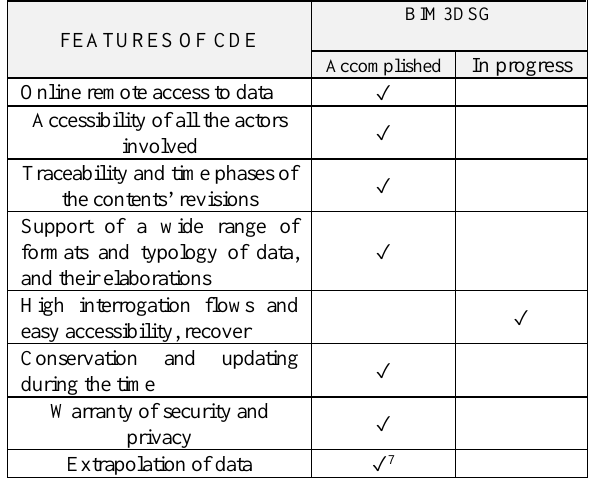
Table 3. The features of CDE are compared with the ones of BIM3DSG, highlighting what it is already capable of accomplishing, and what is still in